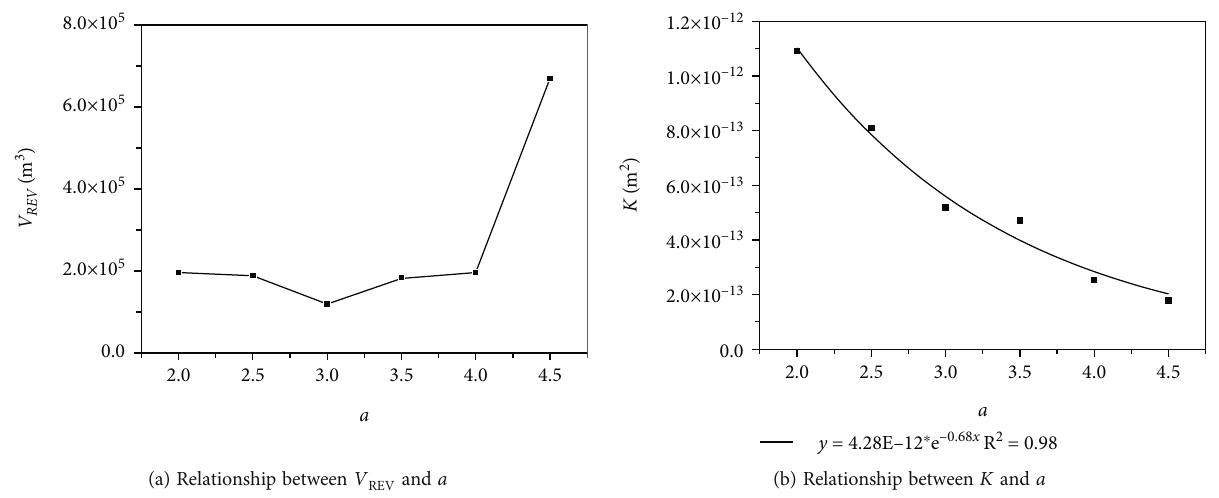
Figure 12: Variations in V